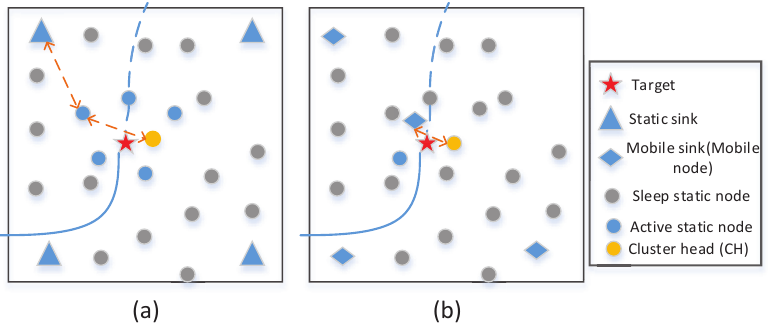
Figure 4. Illustration of the tracking methods based on the static nodes (left, the method used in work [13]) and hybrid nodes (right, the method used in this work): ( a ) four fixed sinks are involved and six static nodes required to form a task cluster to track the target in current timestep; and ( b ) four mobile nodes works in the monitor area and one of them cooperates with the task cluster that only consists of two static